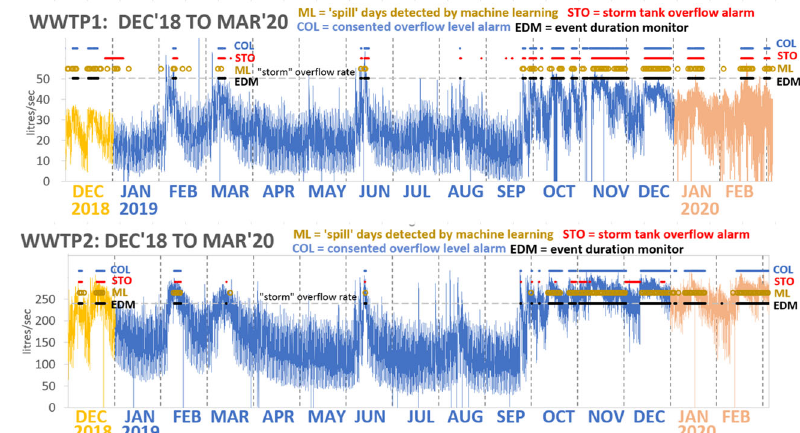
Fig. 4 Daily ef fl uent fl ow patterns and event duration monitor (EDM) detected spill intervals at WTTP1 and WWTP2 used as training data (Dec'2018 – Mar'2020). The daily fl ow and EDM spill data are measured at 15 min intervals. Flow is coloured (orange/blue/pink) to distinguish different years. Black horizontal lines delimit EDM detected spill intervals. Daily fl ows of aggregated spill length of at least/less than 3-h are labelled as ‘ spill ’ / ‘ normal ’ prior to the supervised learning. Gold circles indicate days classi fi ed as ‘ spill ’ following the training of the machine learning (ML) algorithms to produce an optimal classi fi er for each WWTP. The grey dashed line represents the storm over fl ow which de fi nes the minimum sewage fl ow that should be treated even during storm fi lling or over fl ow. Additional annotations are telemetry alarms provided by the operator. These alarms have the potential to corroborate ML predictions of ‘ spill ’ days for the unseen fl ow patterns from 2009 to 2018 for which there is no EDM data. Similar charts showing the unseen ML classi fi cation of the 2009 – 2018 daily fl ow patterns overlaid with rainfall and river level data are provided in Supplementary Figs 5 – 10.